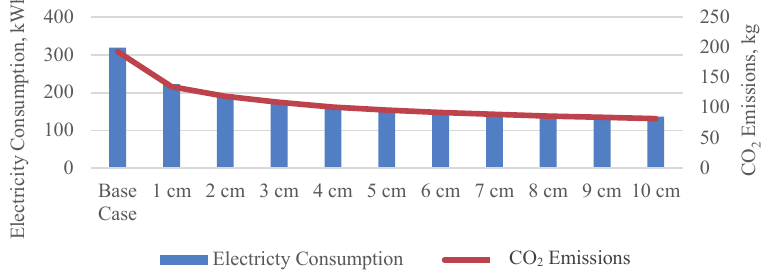
Fig. 4. Total Electricity Consumption and CO 2 Emissions Results for Wall Construction Layers Simulation